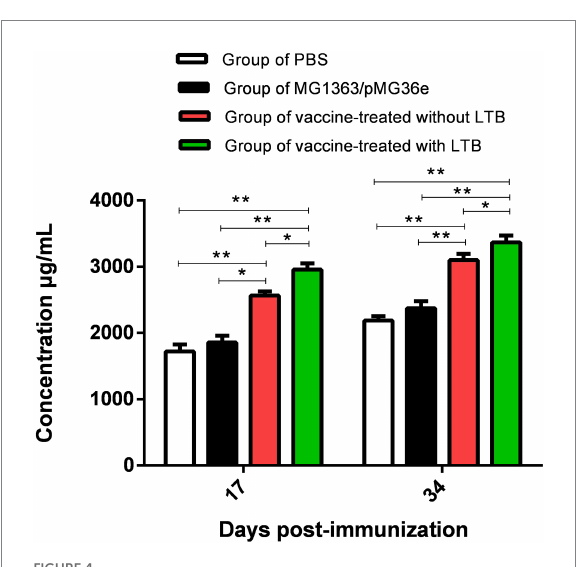
FIGURE 4 Determination of intestinal mucosa sIgA levels on 17 and 34 dpv by ELISA. “**” in the figure means the difference is extremely significant p < 0.01, “*” indicates a significant difference p < 0.05, and “ns” indicates no significant difference p >